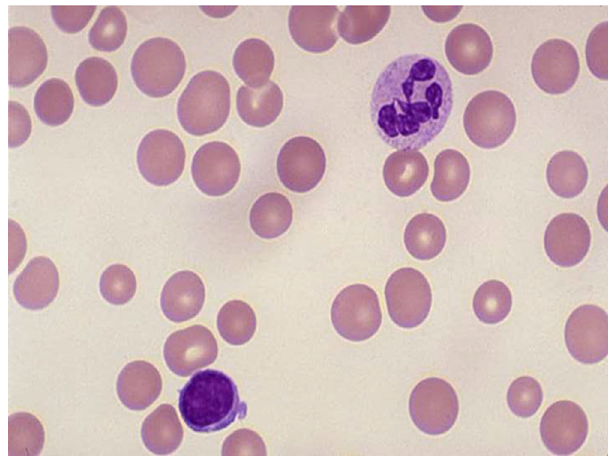
Fig. 2. Peripheral blood smear under 100 (cid:1) magni fi cation showing macrocytic RBCs with hyper segmented neutrophils.